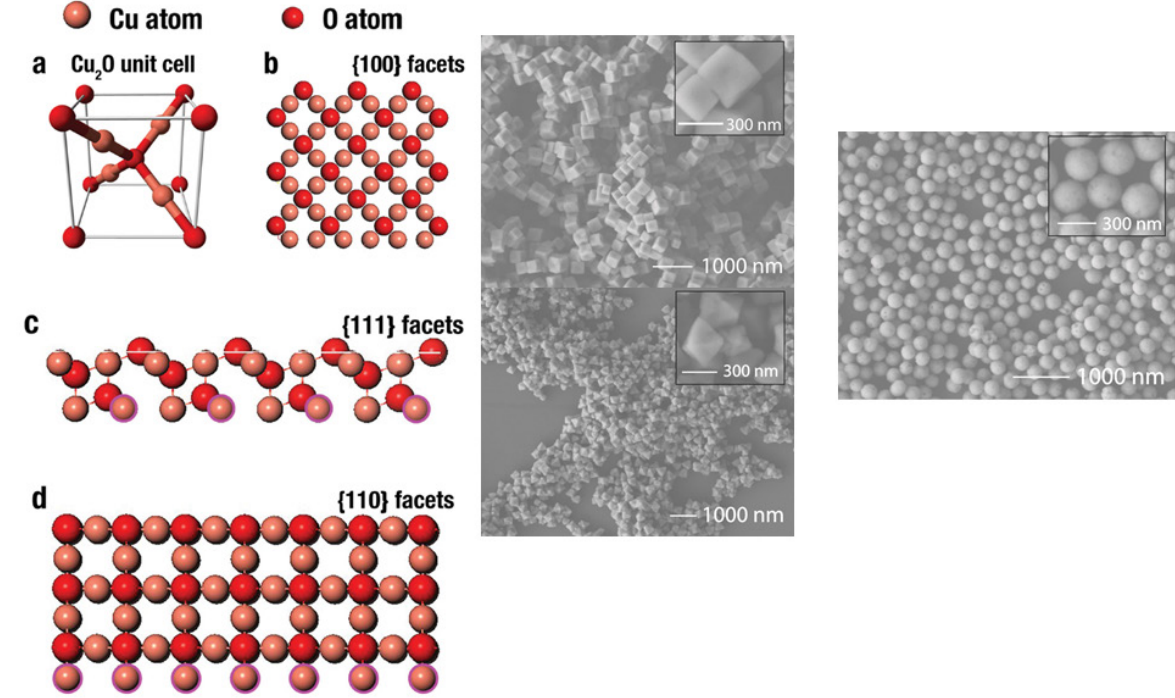
O adapted from (Shang and Guo 2015) and SEM figures 2